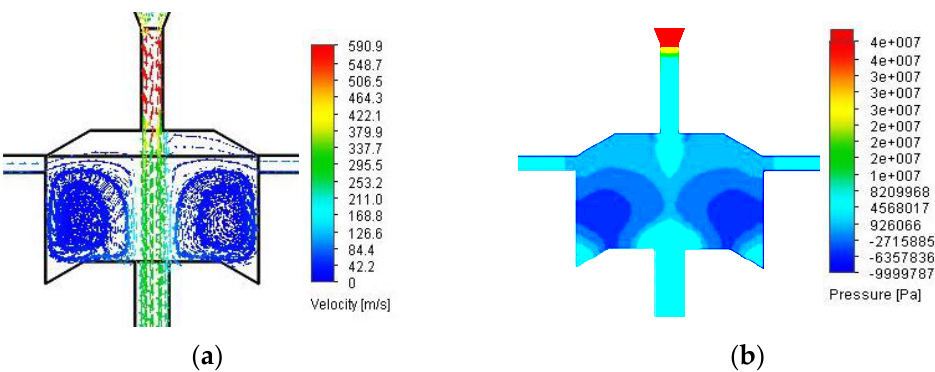
Figure 7. Distribution of velocity vectors: ( a ) and pressure ( b ) inside the selected model of the self-excited pulse head at a nominal pressure of 150 MPa.